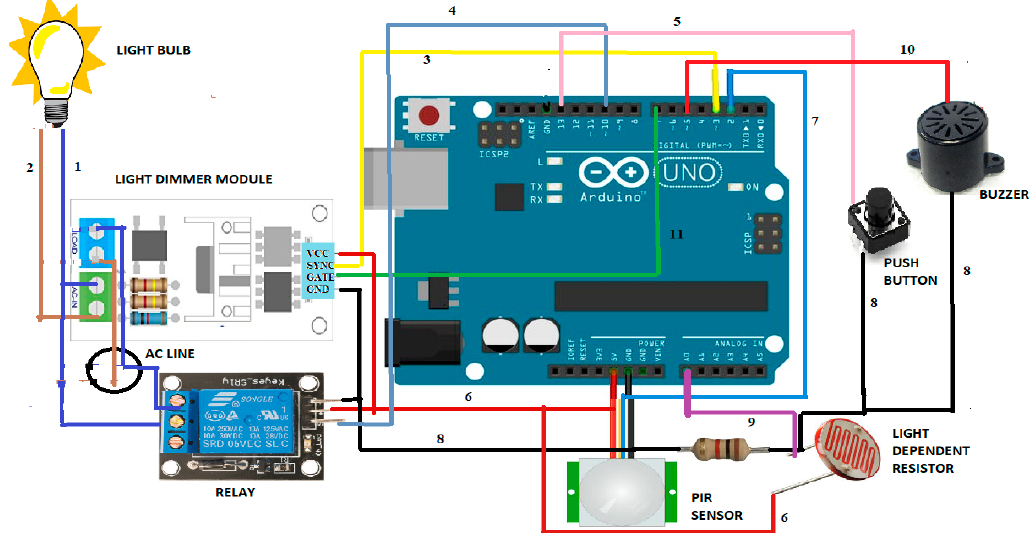
Figure 2. PARSLAD architecture. 1,2—Indicates AC line; 3—SYNC of light dimmer and 3 rd pin of the